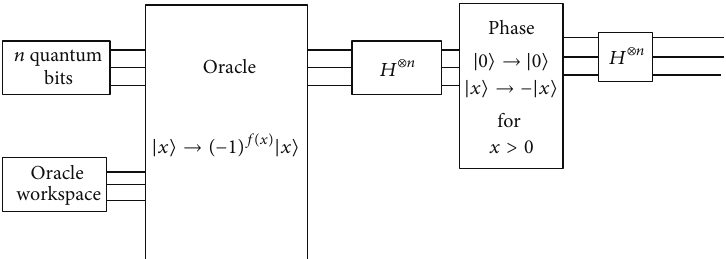
Figure 7: Quantum circuit of Grover